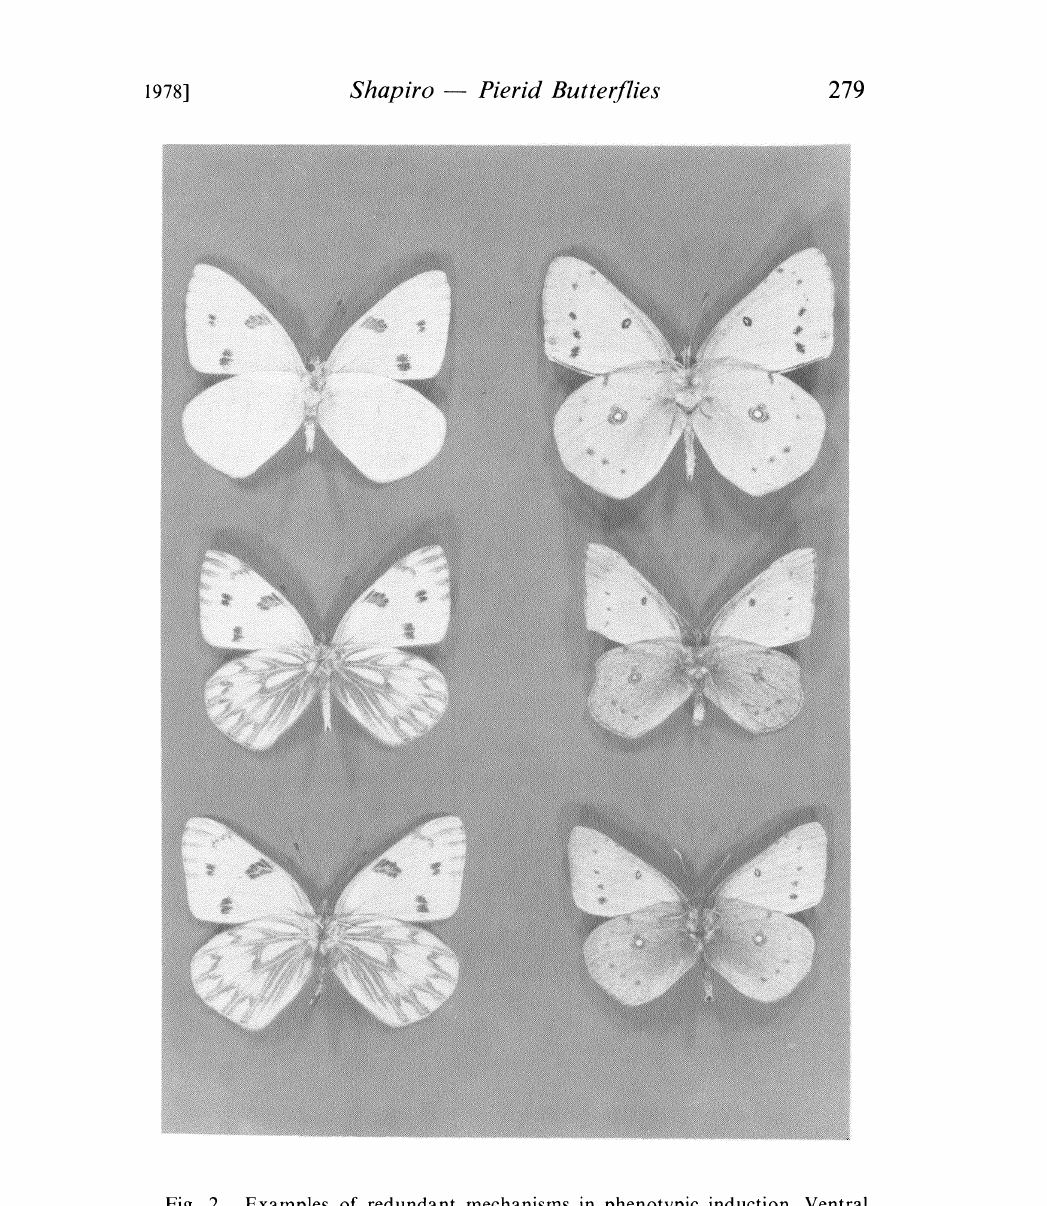
Fig. 2. Examples of redundant mechanisns in phenotypic induction. Ventral surfaces of nales of Pieris protodice (left) and Colias eurytheme (right). Top: estival phenotypes, 24 L:O D, 25 C, pupa unchilled. Center: vernal, sane conditions, young pupa chilled. Bottom: vernal, 10L: 14D, 25 C, pupa